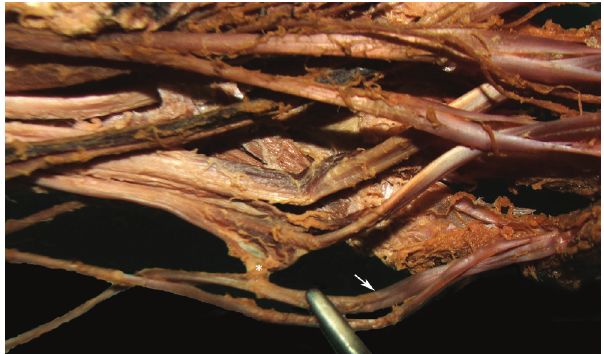
Figure 2 - Close view of the connection between the anomalous tendon and the FDP tendon to the ring finger. The white arrow indicates the FDP tendon originating from the FDS muscle, and the white asterix indicates the intertendinous